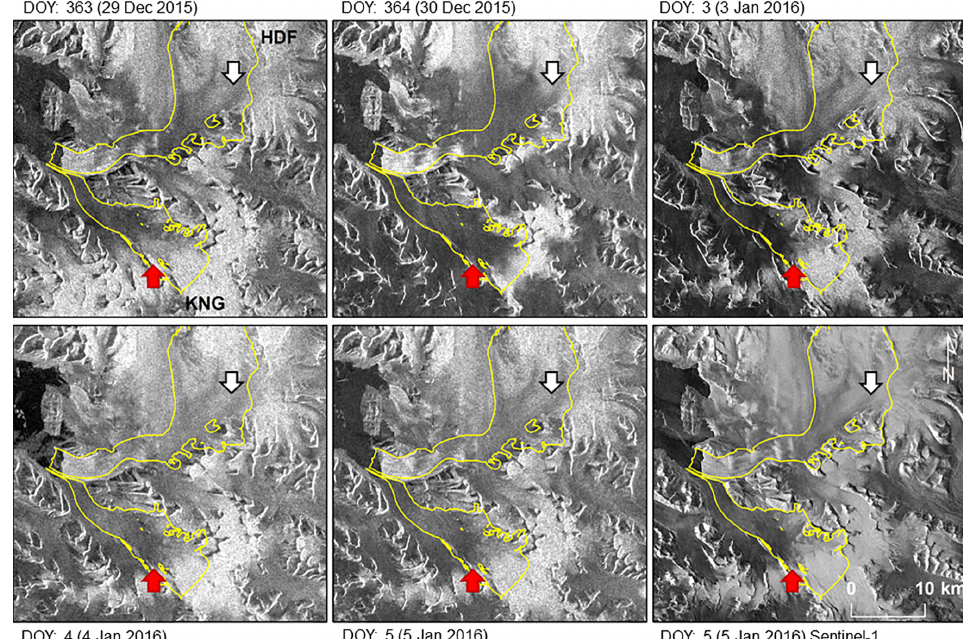
Figure 9. RADARSAT-2 ScanSAR mode backscatter (dB) images from 29 to 30 December 2015 (DOY 363 and 364) and 3–5 January 2016 (DOY 3 to 5). Conditions on Holtedahlfonna were wet on 30 December (see white arrows) but were dry and cold again on 3–5 January 2016 (DOY 3 to 5) (higher backscatter than on 30 December 2015 (DOY 364). Low backscatter values were found on Kongsvegen from 3 to 5 January 2016 (DOY 3 to 5; see red arrows), indicating wetter conditions and more rainfall in this period compared to